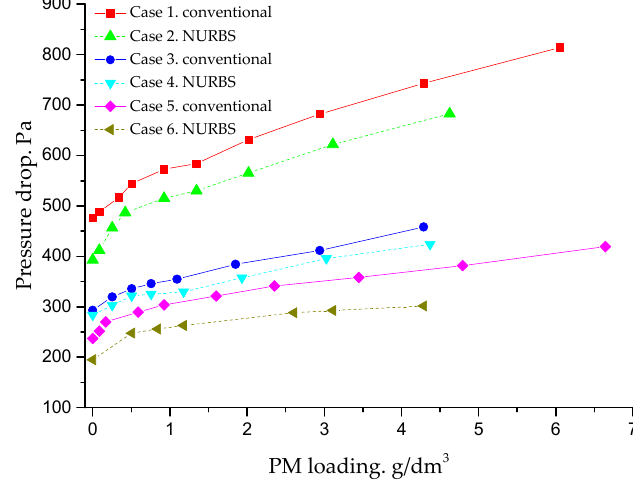
Figure 8. Pressure drop comparison of the 6 cases.